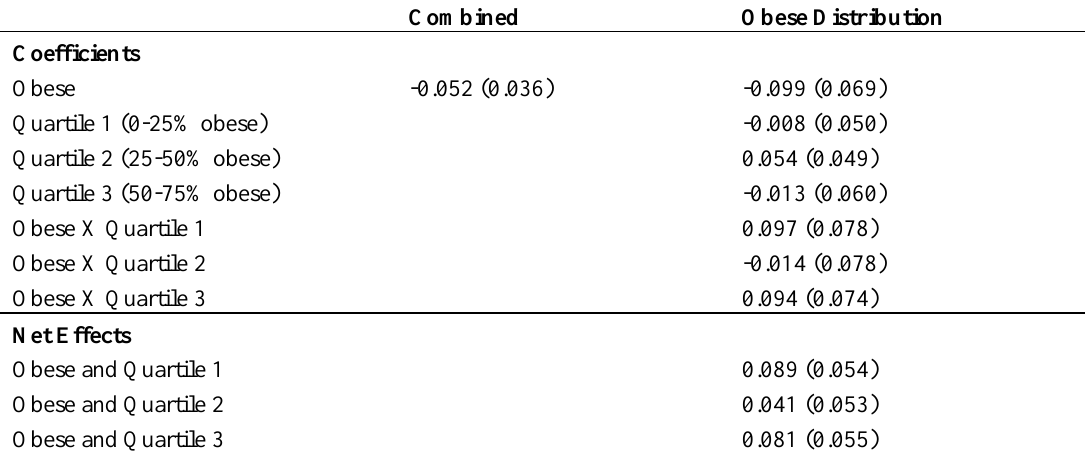
Estimated wage effects of workgroup composition among females Combined Obese Distribution Coefficients -0.052 (0.036) -0.099